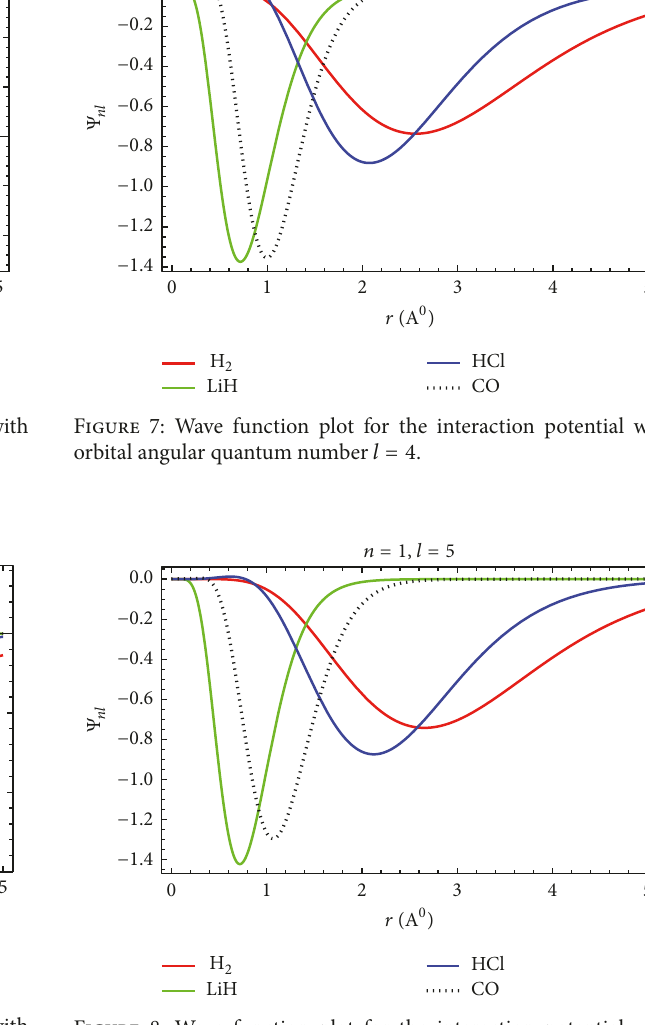
Figure 8: Wave function plot for the interaction potential with orbital angular quantum number 𝑙 = 5